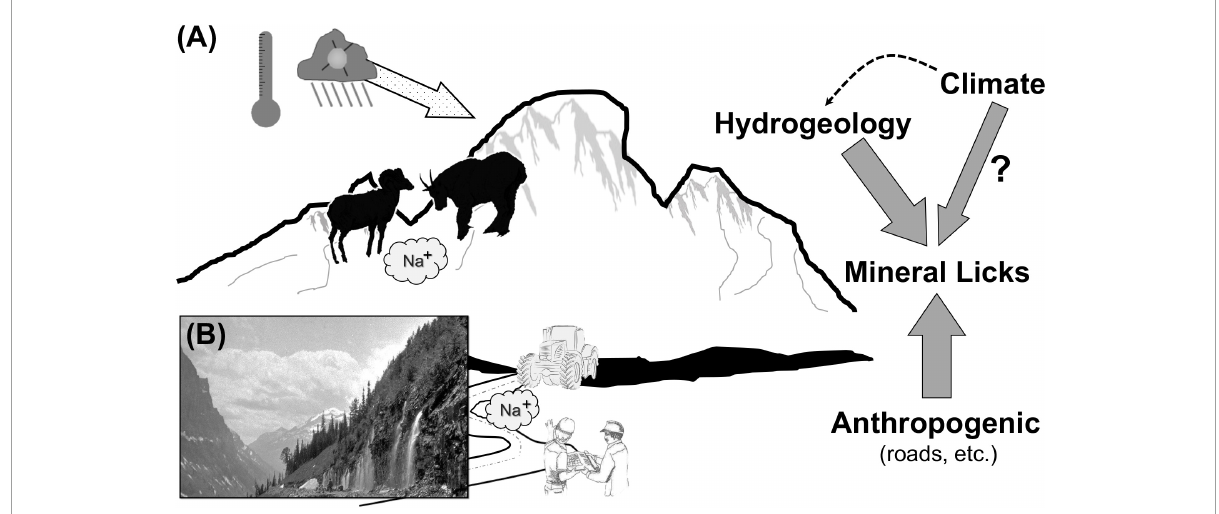
FIGURE1 Representation of hypothesized pathways leading to high elevation conflict. (A) Temperature-based melting of glaciers facilitates availability of mineral licks coupled with their loss to geophagous ungulates by highways construction; (right) hydro-geomorphic changes to mineral availability, and (B) 1927 photograph of excessive subterranean-to-surface water flow (Glacier National Park archive